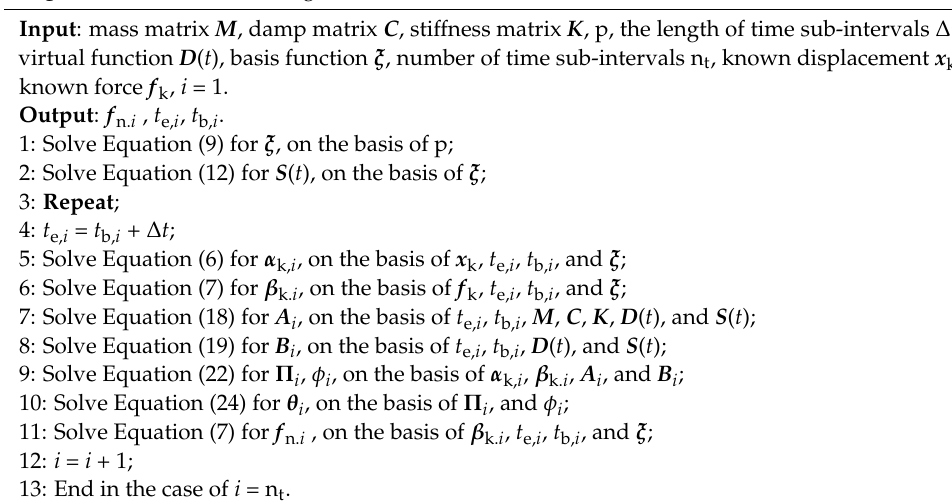
Algorithm 1: The solution algorithm for load